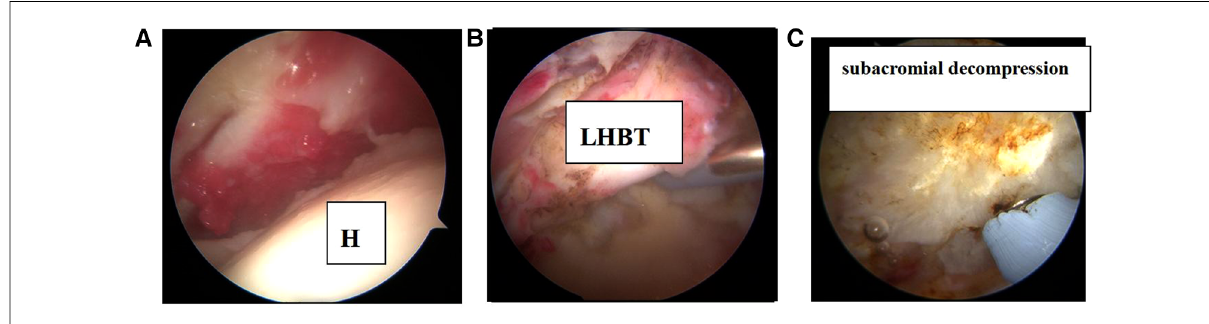
FIGURE 2 Arthroscopic images of the rotator cuff tear in the right shoulder in patient 2. ( A ) Irreparable rotator cuff tears; ( B ) rupture of the long head of the biceps brachii tendon; ( C ) arthroscopic subacromial decompression to create a fl at acromial undersurface. H, humeral head; LHBT, long head of the biceps brachii